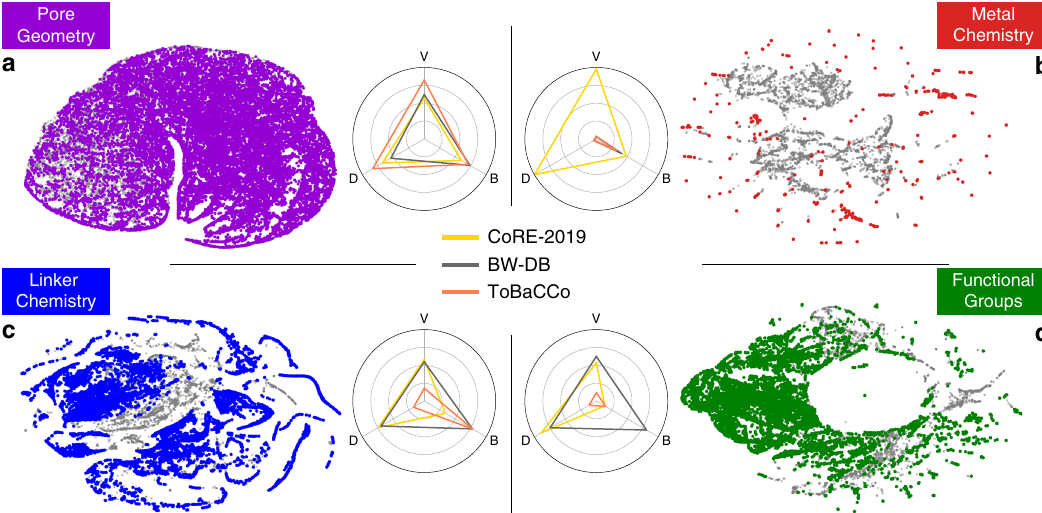
Fig. 3 Diversity metrics and maps of different domains of MOF structures. The t-SNE method was used to project the a pore geometry, b metal chemistry, c linker chemistry and d functional groups descriptor spaces to 2D maps. Only descriptors up to the second coordination shell were included for metal chemistry to emphasize the local metal chemistry environment. In each panel, the structures from the hypothetical databases are coloured and overlaid on the entire known design space represented in grey. The radar charts show the three diversity metrics: variety (V), balance (B) and disparity (D), for the three databases. For this analysis, fi rst we discretize the space into a fi xed number of bins. Variety measures the number of bins that are sampled, balance the evenness of the distribution of materials among the sampled bins, and disparity the spread of the sampled bins (see the “ Methods ” section for more